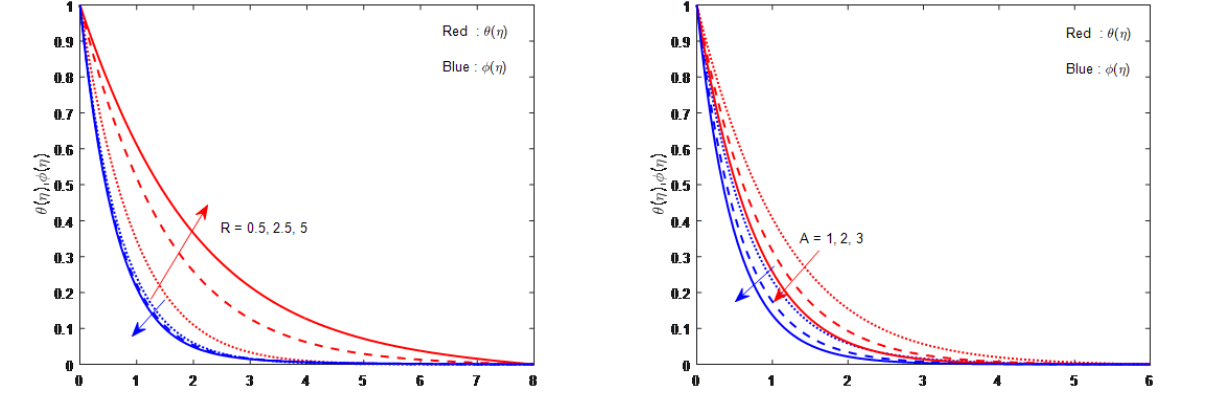
to mention that β significantly affects the temperature pro- files while compared with concentration